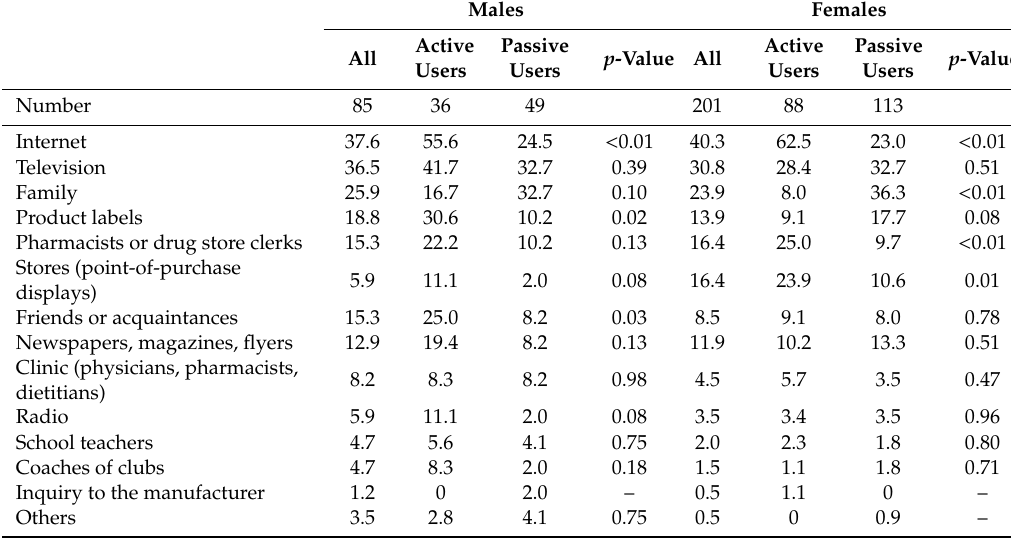
Table 3. A comparison of the sources of information regarding dietary supplements in active and passive users (% of